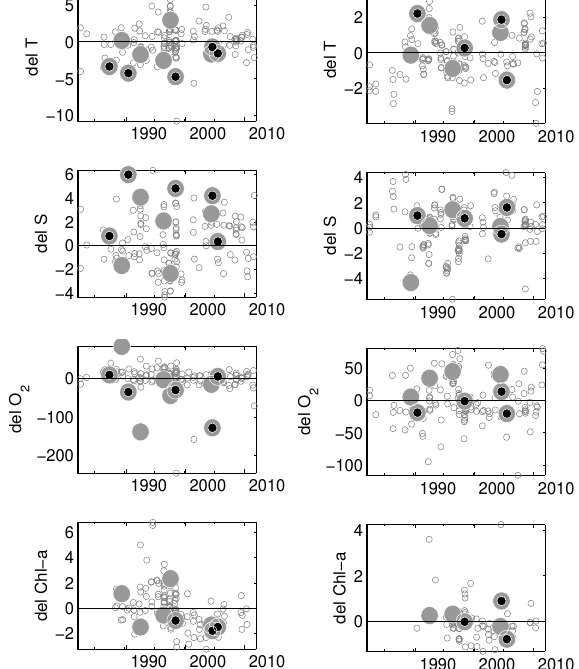
Figure 6. Summer (June to September) anomalies (relative to long- term monthly mean, see Fig. 5) of single BE surveys between 1982 and 2012. Left: averaging all data above 2m. Right: averaging data below 24m (right). Grey (black) dots indicate the anomalies that are associated with the 10 (5) strongest 1.5 day wind impulses (see Table